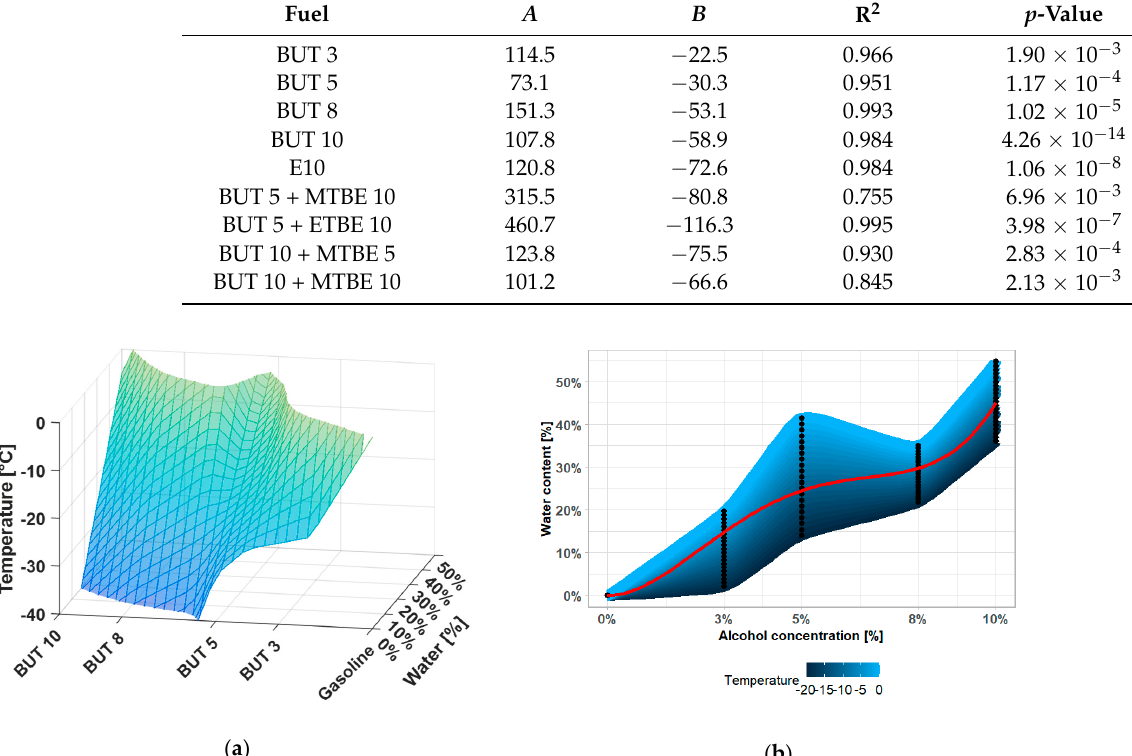
Figure 8. ( a ) Surface plot of nonlinear relation among the temperature, water content, and n-butanol-gasoline mixture composition; ( b ) projection of surface plot to two-dimensional (2D) gradient plot of nonlinear relation among the variables.